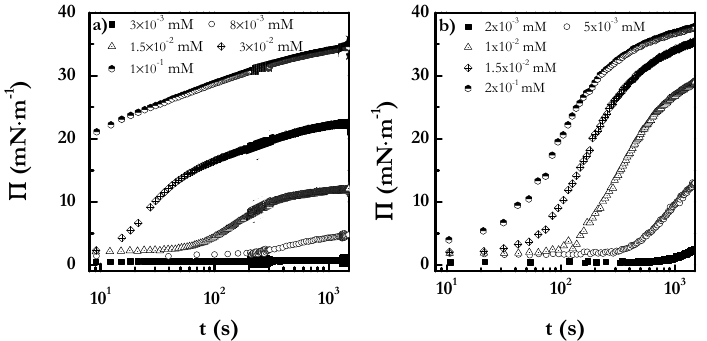
Figure 4. ( a )DynamicsurfacepressureforPDADMAC-SLMTsolutionswithdifferentsurfactantconcentrations. Figure 4. ( a ) Dynamic surface pressure for PDADMAC-SLMT solutions with different surfactant ( b )DynamicsurfacepressureforPDADMAC-SLESsolutionswithdifferentsurfactantconcentrations. Theresults concentrations. ( b ) Dynamic surface pressure for PDADMAC-SLES solutions with different correspond to PDADMAC-surfactant mixtures containing a fixed PDADMAC concentration of 0.5 wt.%, and surfactant concentrations. The results correspond to PDADMAC-surfactant mixtures containing a left to age for one week prior to fixed PDADMAC concentration of 0.5 wt.%, and left to age for one week prior to measurement.